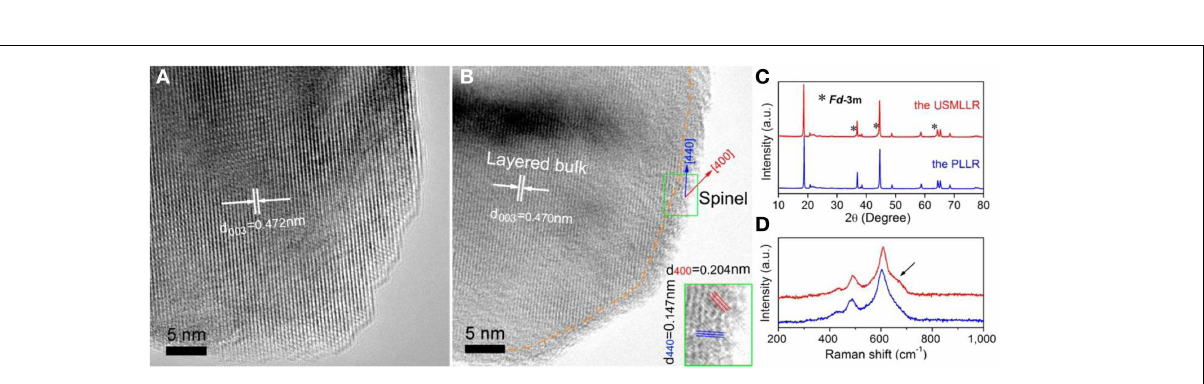
FIGURE 3 | HRTEM images of the pristine layered lithium-rich materials (PLLR) sample (A) and the ultrathin spinel membrane encapsulated- layered lithium-rich cathode (USMLLR) sample (B) .The inset is two times